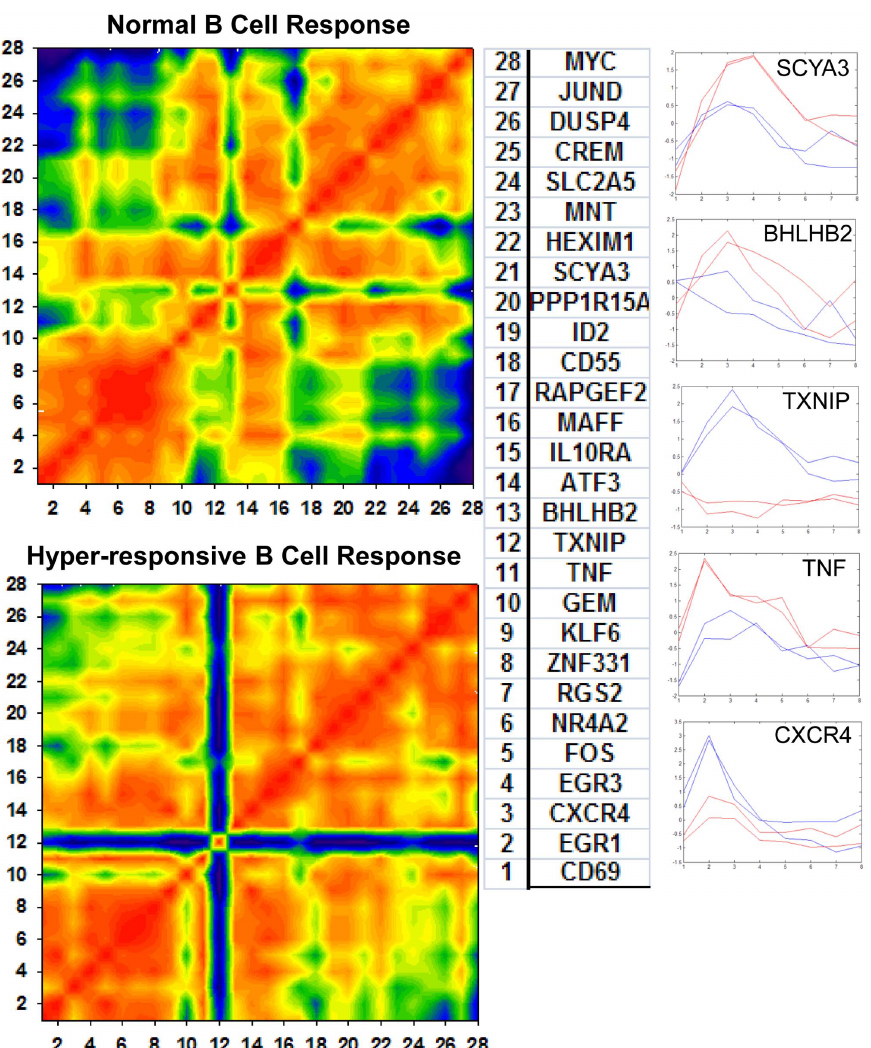
Figure 7. Correlative gene associations in normal B cell responses and in hyperresponsive B cell responses. Pearson correlation was utilized to estimate the correlation coefficients. Negative correlations are shown in blue; while positive correlations are shown in red. Genes examined are listed in table on the left. Gene numbers (right column) are used as coordinates along x and y-axis. Select gene expression graphs are shown on the far right with the two SLE patient cell lines depicted in red and the two control cell lines depicted in blue. The order of genes is maintained giving clear visualization of differences in gene associations.